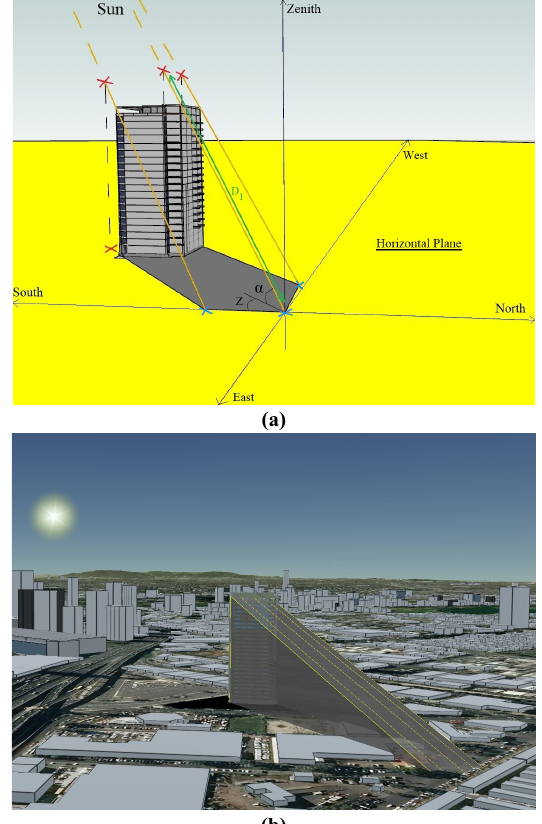
Figure 6 . a) Extracted points (red multiplication signs) based on α (i), z (i), and D (i) for the 2D shadow points; b) Energy efficiency protection and overshadowing open space regulations in 3D using B-Rep